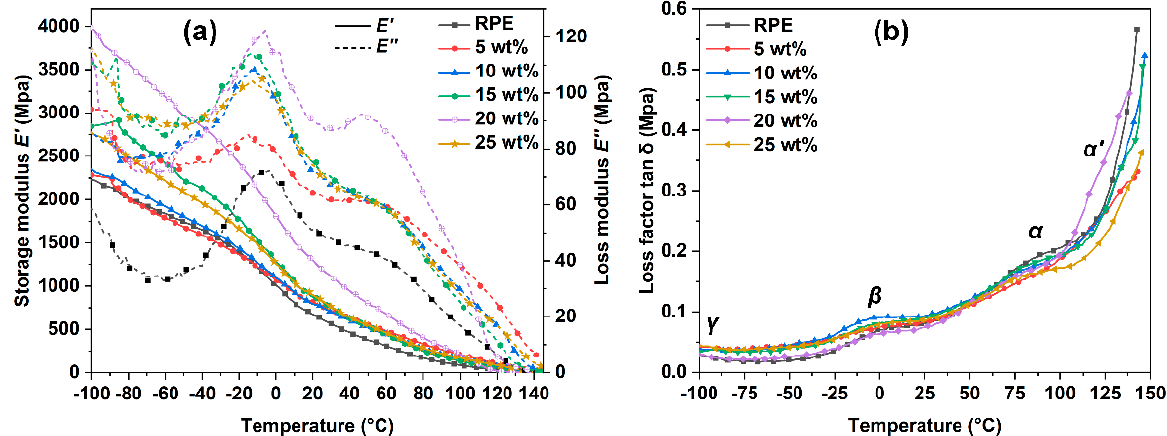
Figure 5. Storage modulus E ′ ( a ), loss modulus E’’ ( a ) and loss factor tan δ ( b ) of RPE and RPE/WPF composites.